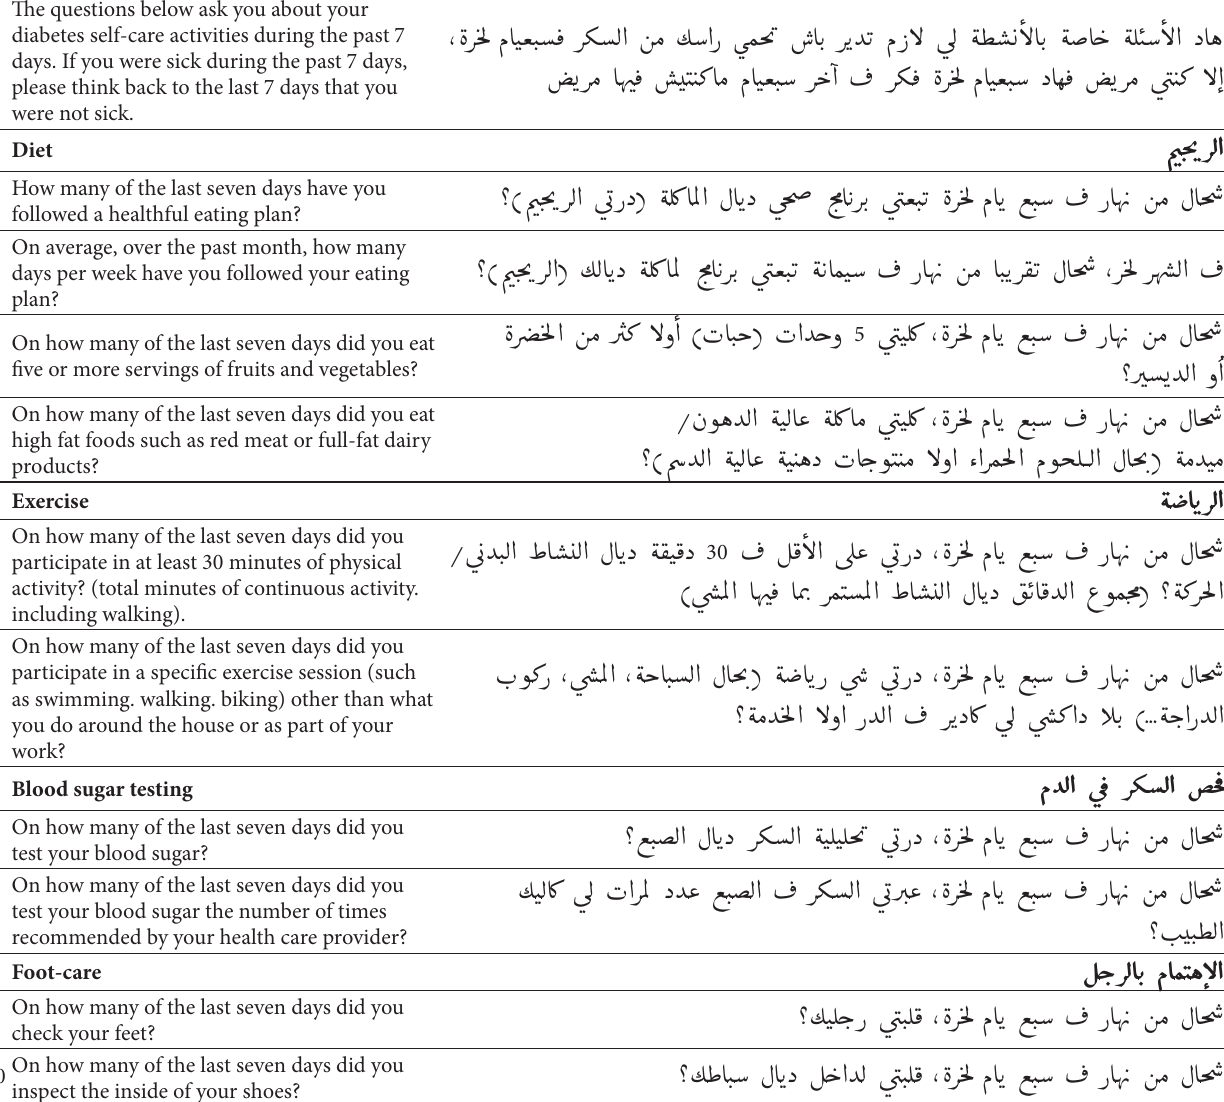
Table 6: The Moroccan Summary of Diabetes Self-Care Activities